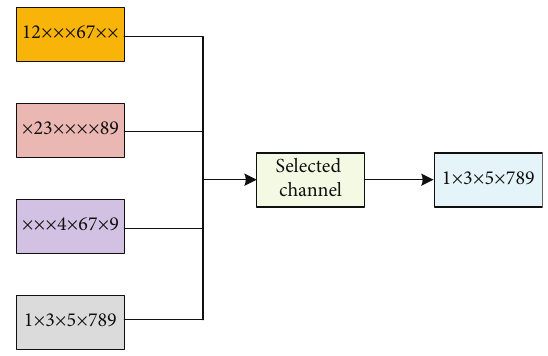
Figure 2: Multi-channel voice signal